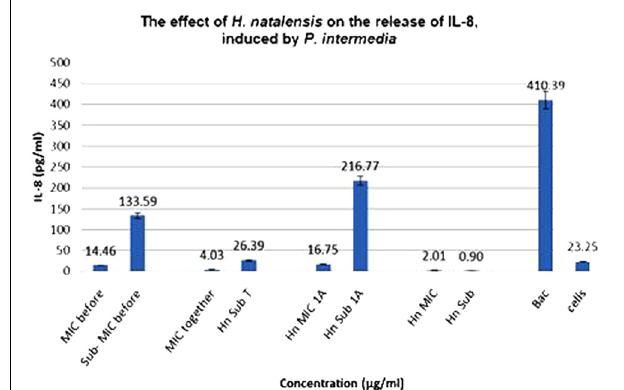
FIGURE 2 | The effect of Heteropyxis natalensis on the release of IL-8, taken in a time-dependent manner at an IC 50 and Sub-IC 50 concentration; as compared to the controls, Prevotella intermedia only (Bac,) and cells only. (Treatment 1 at MIC = MIC before; Treatment 1 at Sub-MIC = Sub-MIC before; Treatment 2 at MIC = MIC together; Treatment 2 at Sub-MIC = Hn Sub T; Treatment 3 at MIC = Hn MIC 1 A; Treatment 3 at Sub-MIC = Hn Sub 1